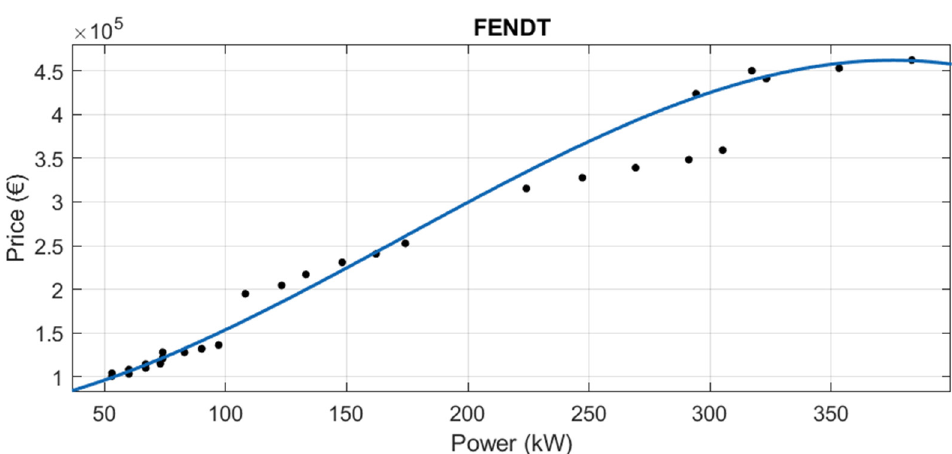
Figure 6. Price vs. power for Fendt new tractors.